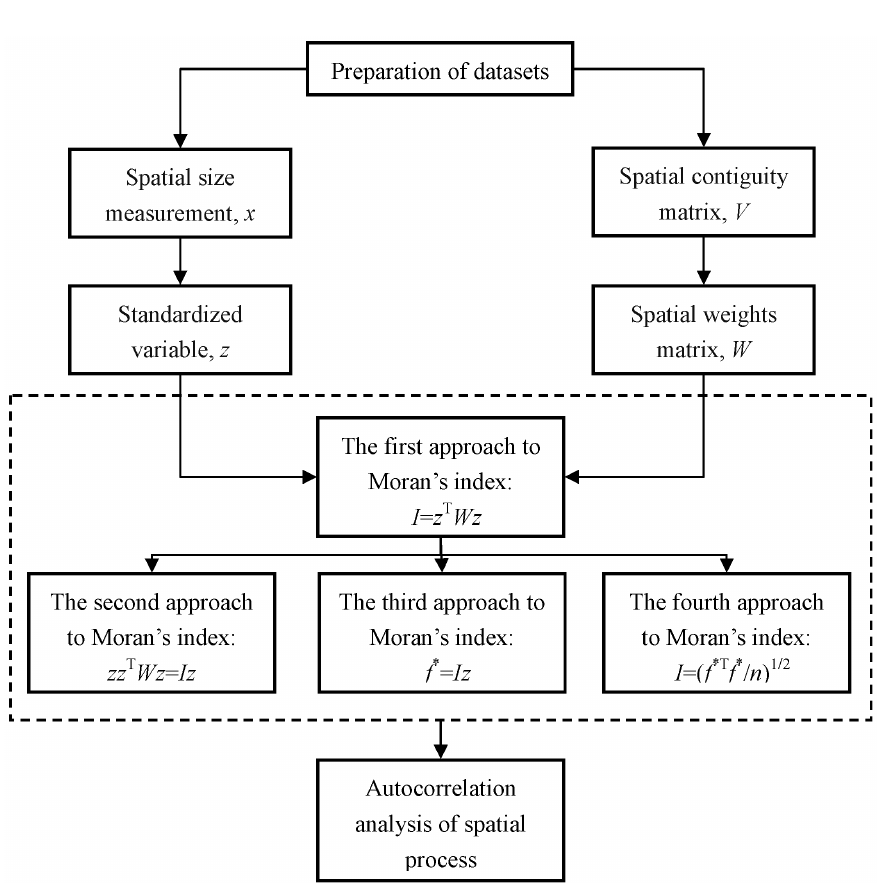
Figure 1. A flow chart of data processing, parameter estimation, and autocorrelation analysis. doi:10.1371/journal.pone.0068336.g001 PLOS ONE |